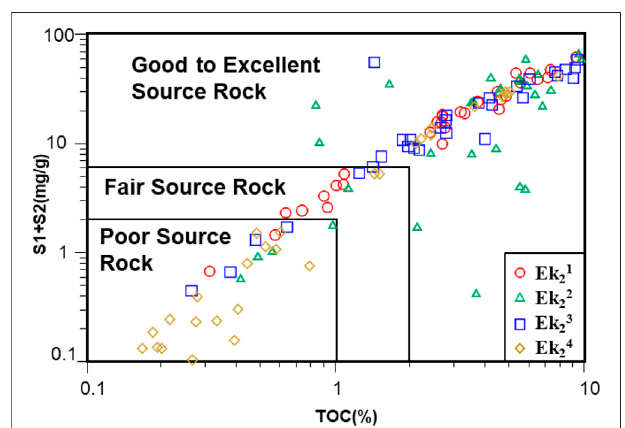
FIGURE 4 | Diagrams of S 1 + S 2 versus TOC content showing generative source rock potential; the classi fi cation standard distinguishes